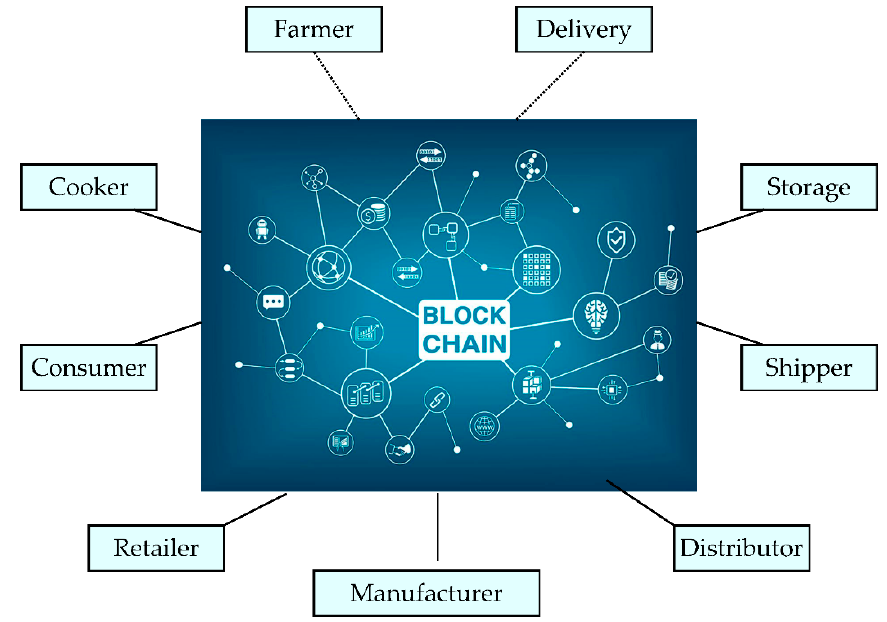
Figure 2. Blockchain participants in the food supply chain.